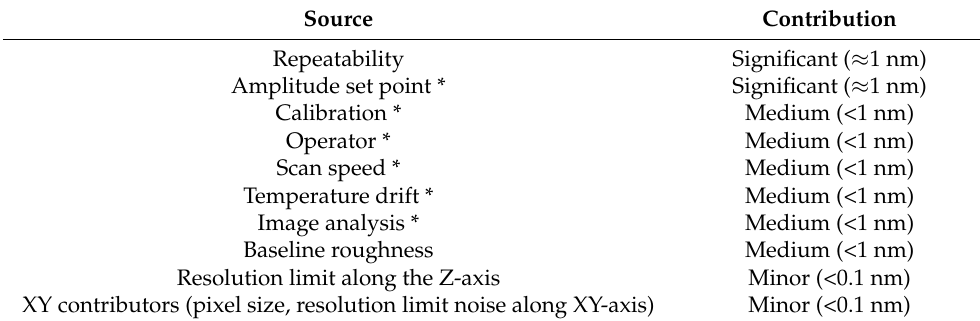
Table 5. Sources of uncertainty for NP size measurements by AFM (k =